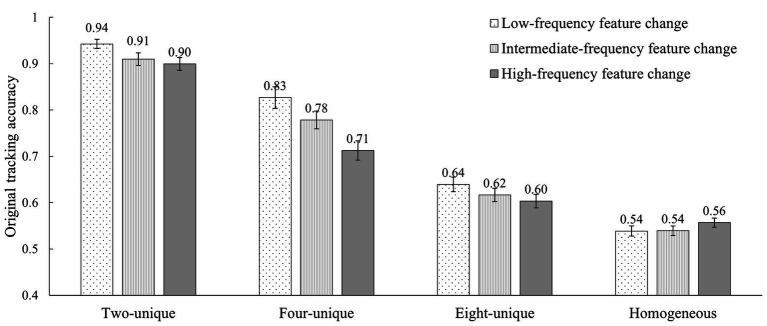
The tracking accuracies of the 12 conditions in Experiment 2 (error bars show ±1 standard error of the mean).